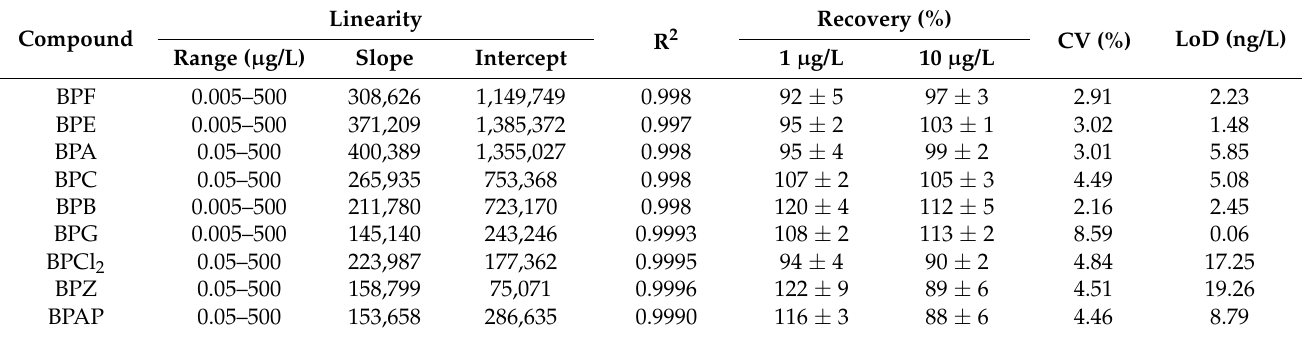
Table 5. USAEME–GC–MS method validation parameters determined with water as a sample matrix.